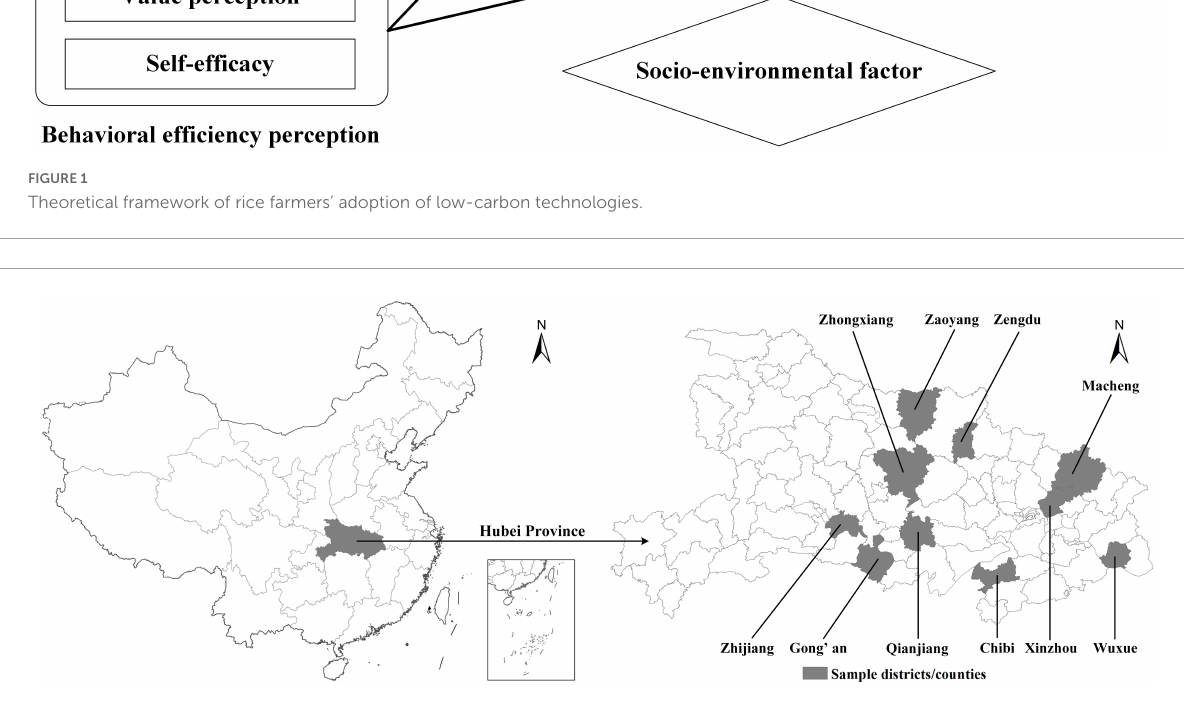
FIGURE2 Survey region and sample